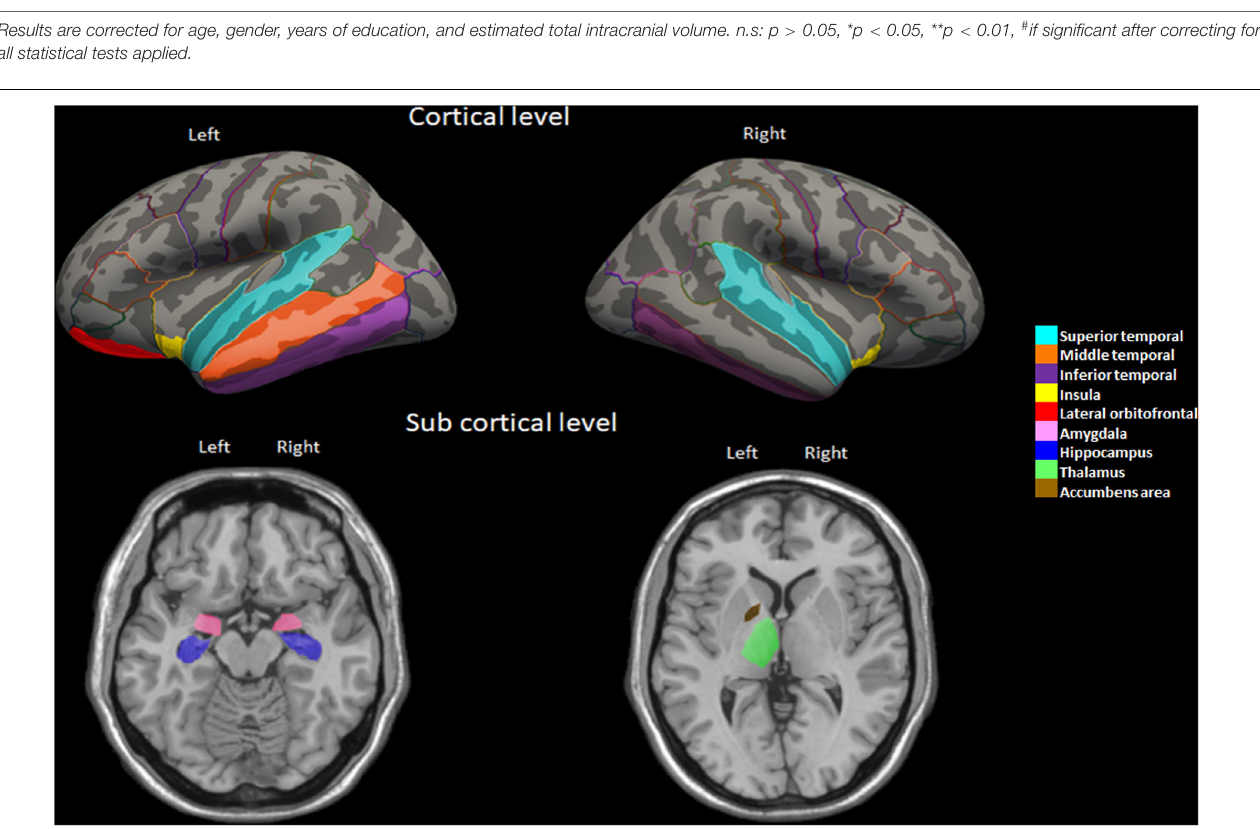
FIGURE 3 | Brain regions highlighting the significant partial correlations between volume and functional impairment in the PCD